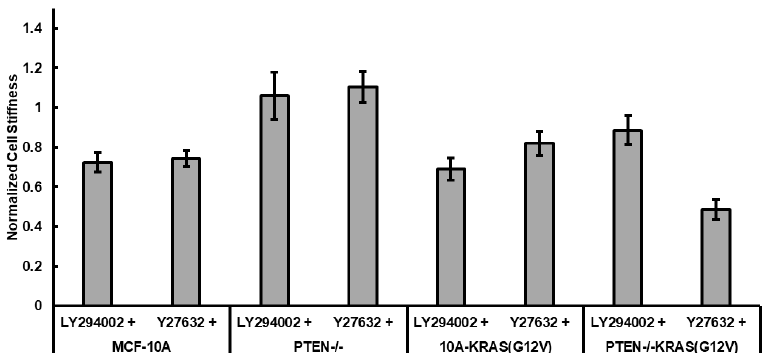
Figure 5. Effects of PI3K inhibitor and ROCK inhibitor on stiffness of MCF-10A, PTEN − / − , 10A-KRAS(G12V), and PTEN − / − KRAS(G12V) cells. Cells are seeded on collagen-coated substrates and treated with 20 µM LY294002 or 10 µM Y27632. Cell stiffness is normalized to the untreated cell stiffness of the same cell type. Number of cells measured: n = 14–33.